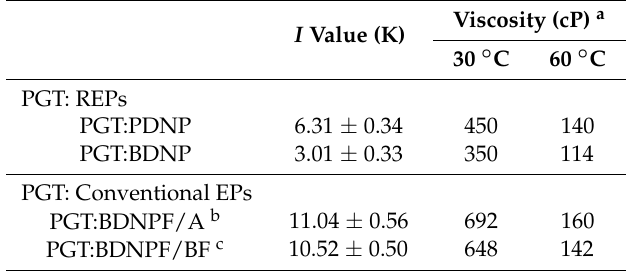
Table 1. Summary of the plasticization effect of REPs and EPs on the PGT prepolymer. I Value